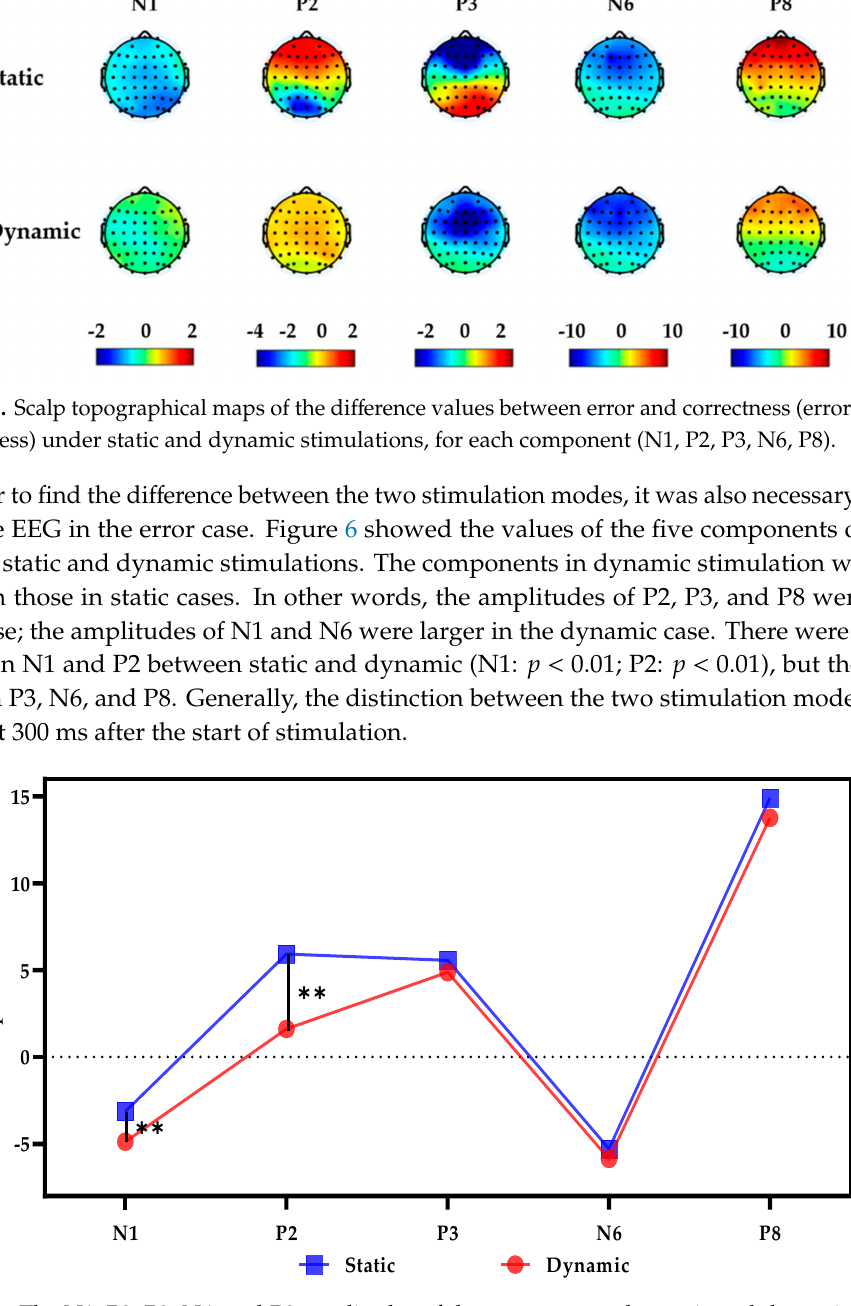
Figure 6. The N1, P2, P3, N6, and P8 amplitudes of the error case under static and dynamic visual stimulations. **: p ≤